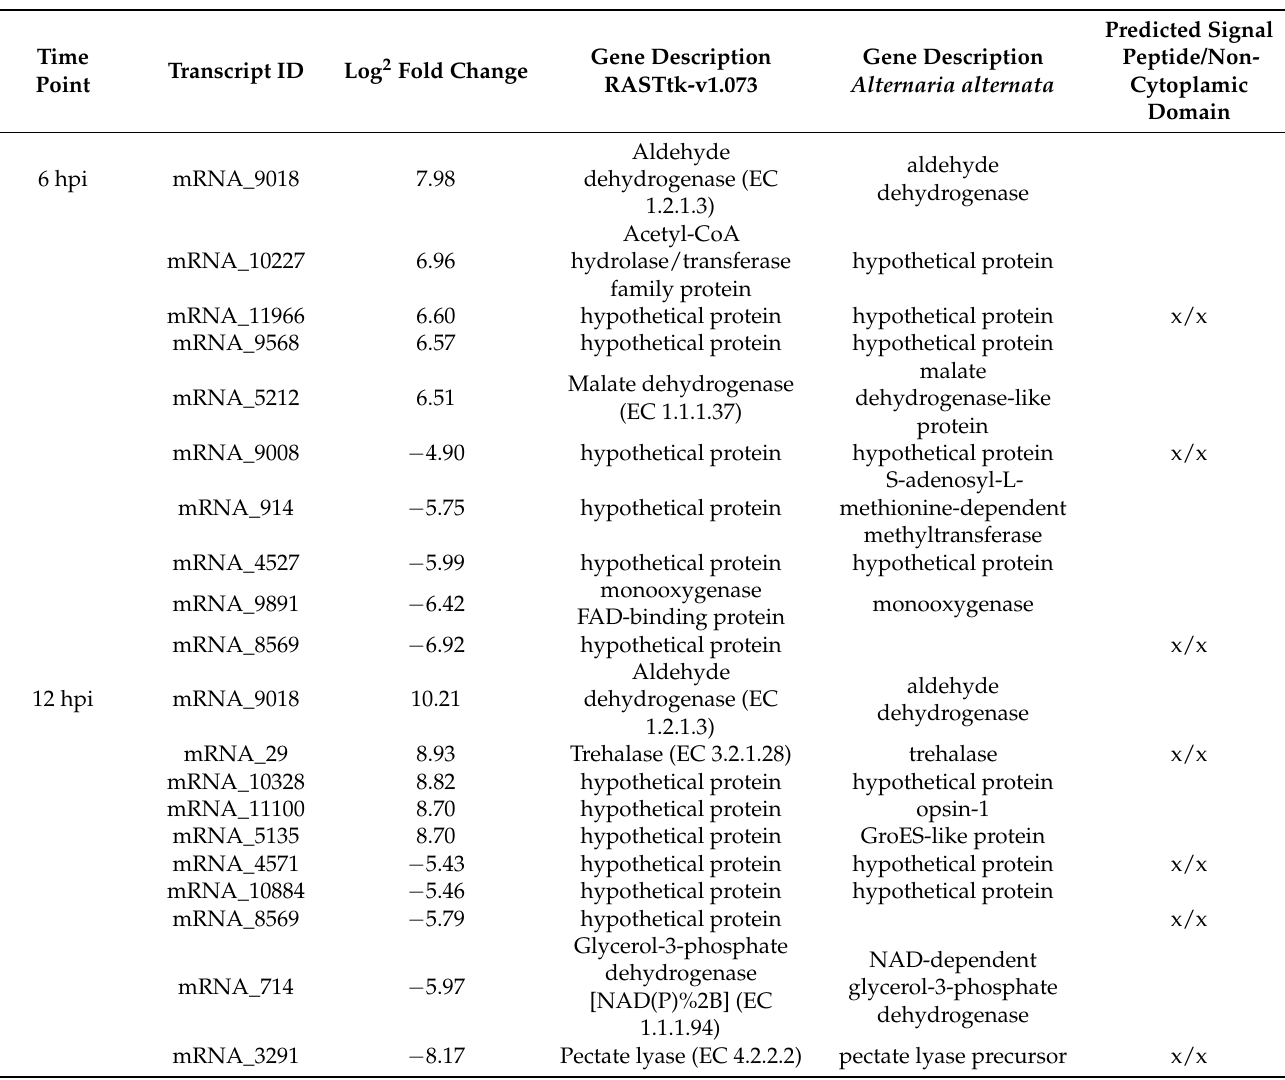
Table 4. Top 5 up- and downregulated A. solani transcripts at 6, 12, 24 and 48 hpi compared to 1 hpi. Transcript ID, log2 Fold change, and the gene descriptions based on the RATtk v1.073 and BLAST analysis are displayed. Predicted signal peptide determined by SignalP 5.0 with likelihood > 0.9, and predicted non-cytoplasmic domain based on InterPro analysis [12]. x indicates